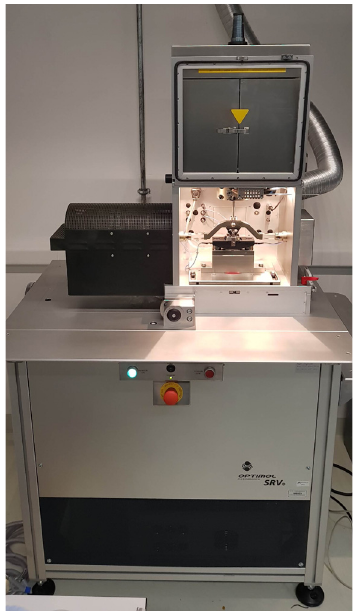
Figure 2. Optimol SRV ® 5 tribometer, which was used for the tribological investigation of the lubricant samples (picture of the authors)